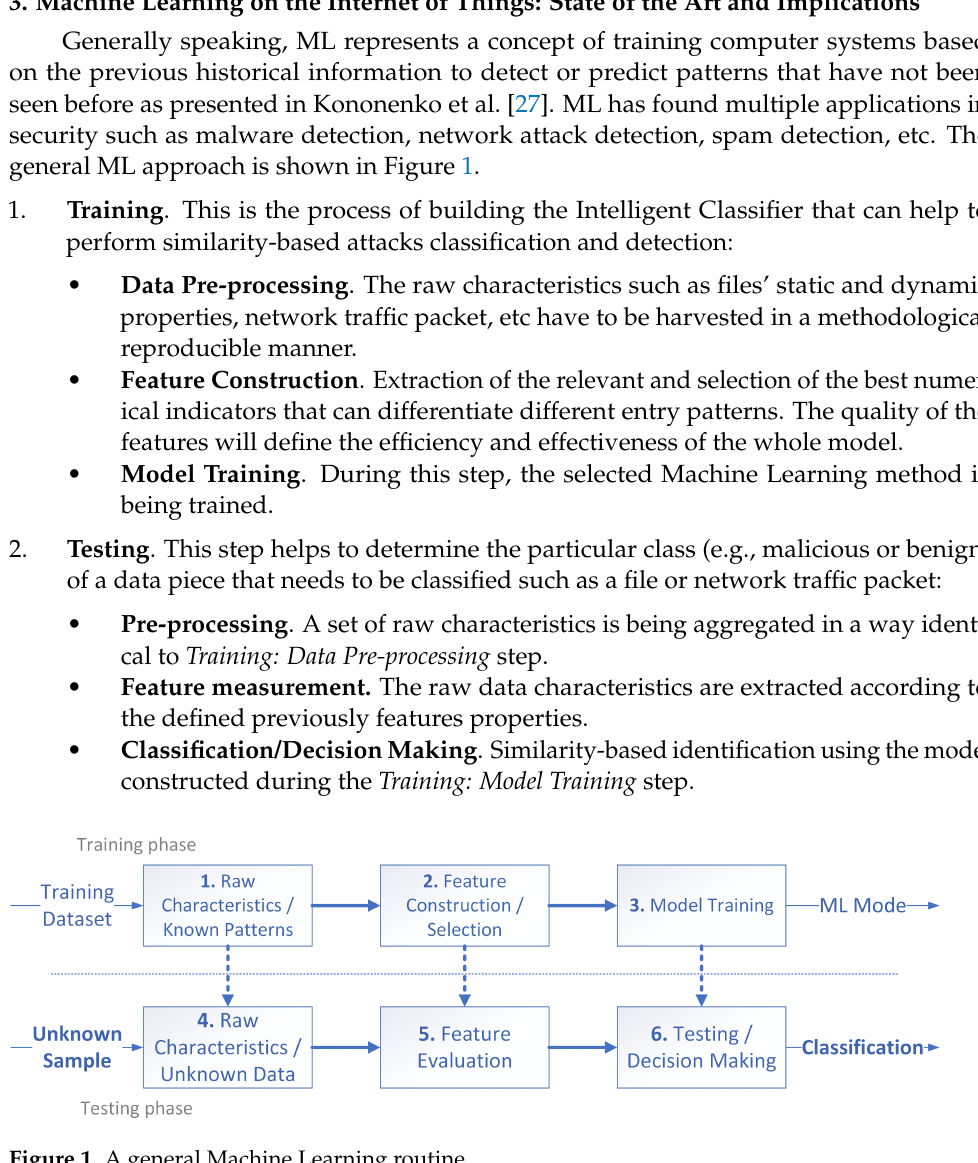
Figure 1. A general Machine Learning